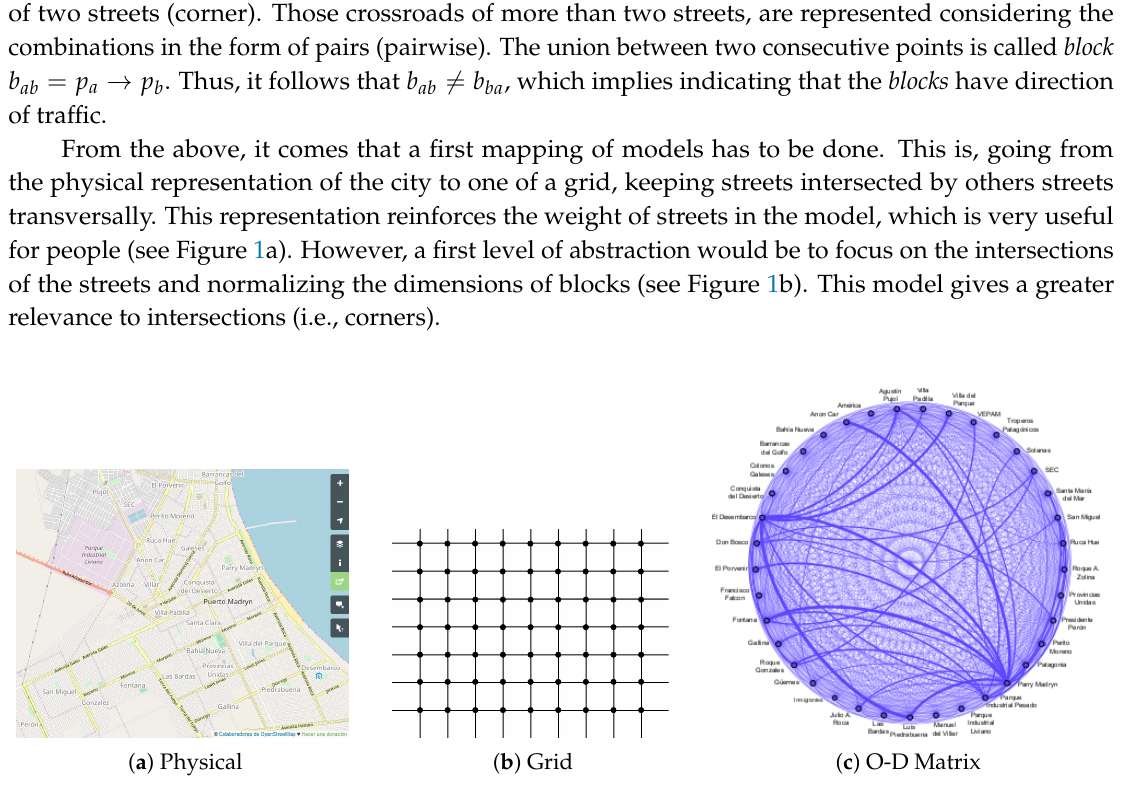
Figure 1. Mappings of models of a